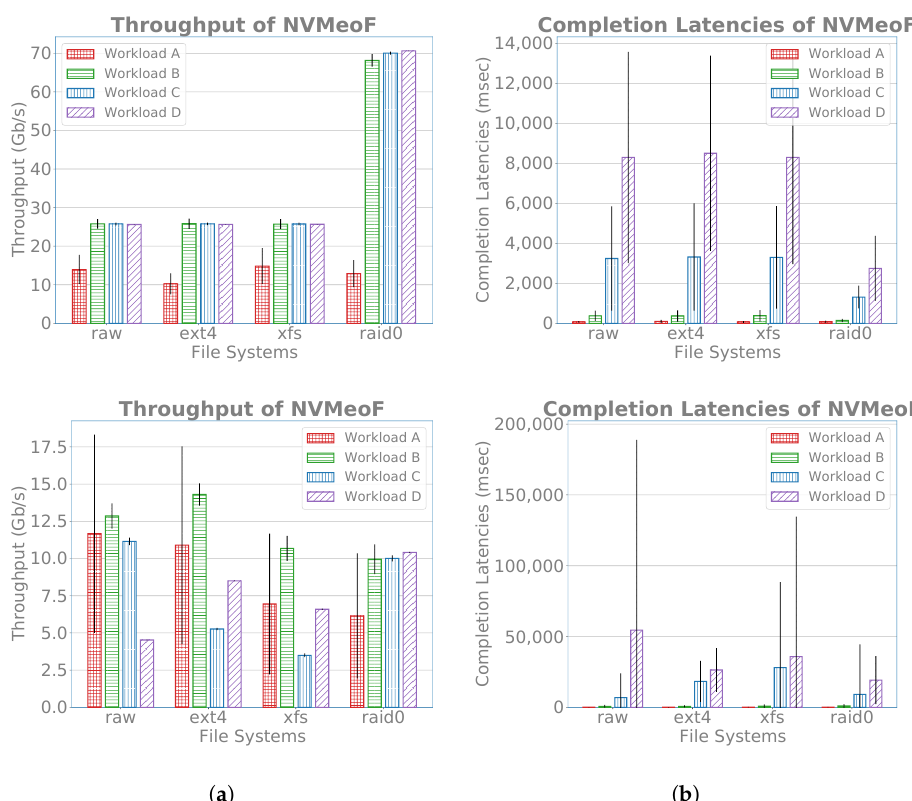
Figure 5. Average and standard deviation of read ( a ) and write ( b ) performance for Ciena DTN using 16 KB inline data size.